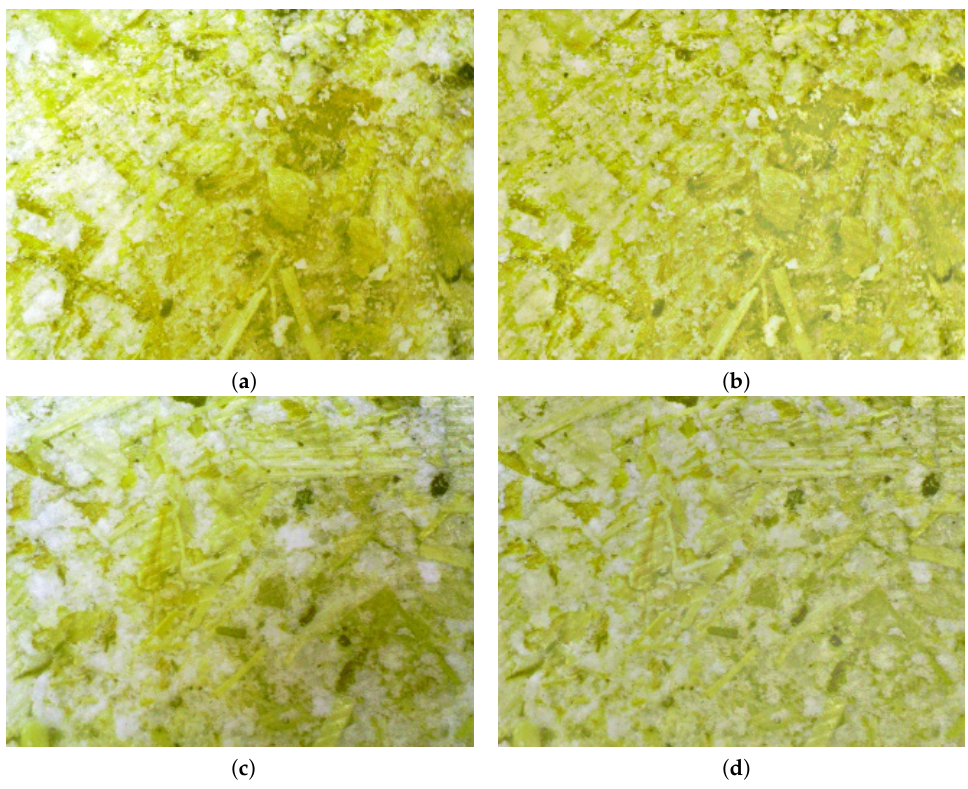
Figure 10. Effect of equalizing the lighting of sample biofuel images, ( a , c )—images from class 1 and 2 with uneven lighting, ( b , d )—the same images after lighting equalization.